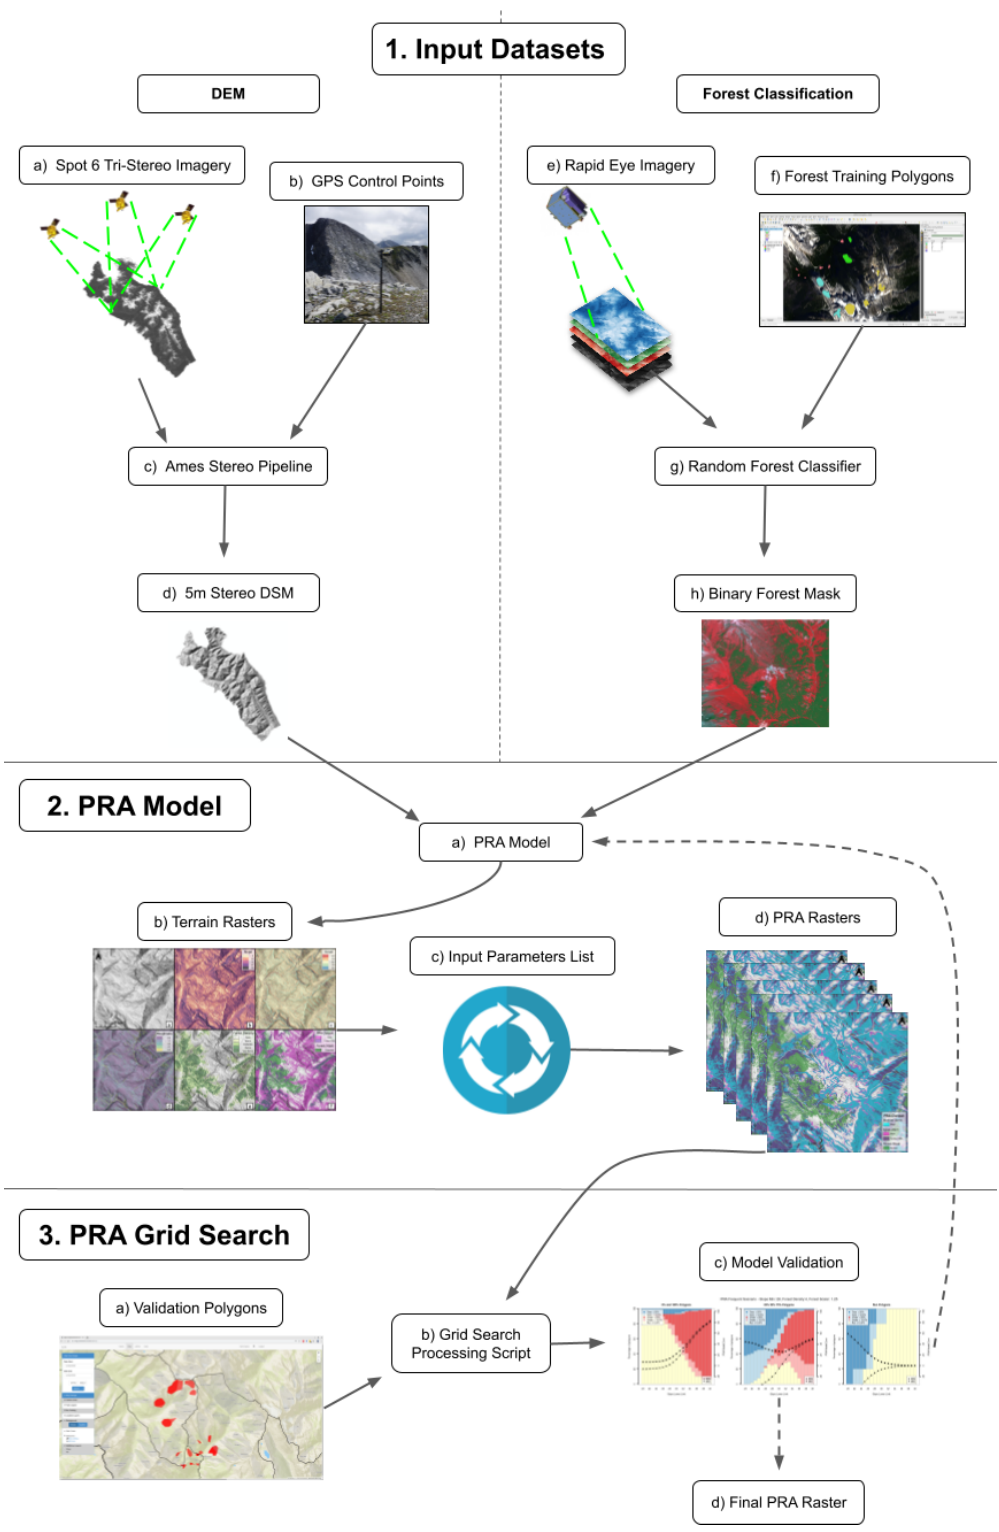
Figure 1. Workflow diagram illustrating the necessary input datasets and processing steps to apply and validate the PRA model in our remote, data-sparse, and forested study area. The dashed lines in step 3c indicate the option to either refine the baseline input parameters of the PRA model and re-start from step 2a or select the final PRA model and move to step